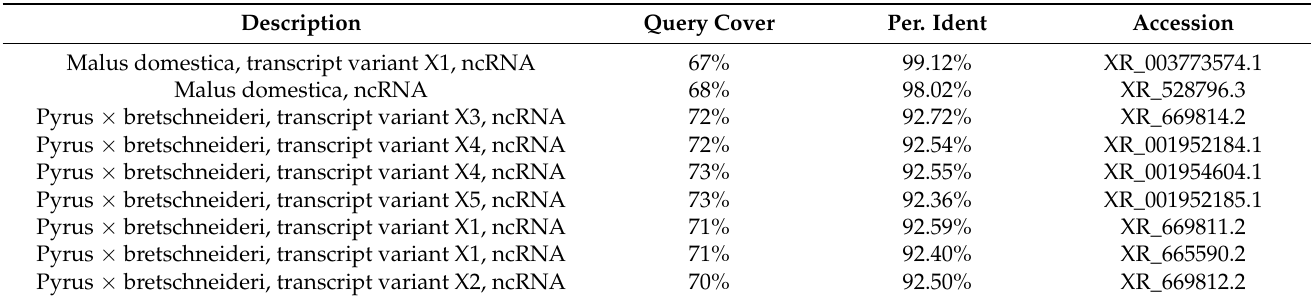
Table 1. Hits of Blast search GenBank using the 1.3 kb insertion